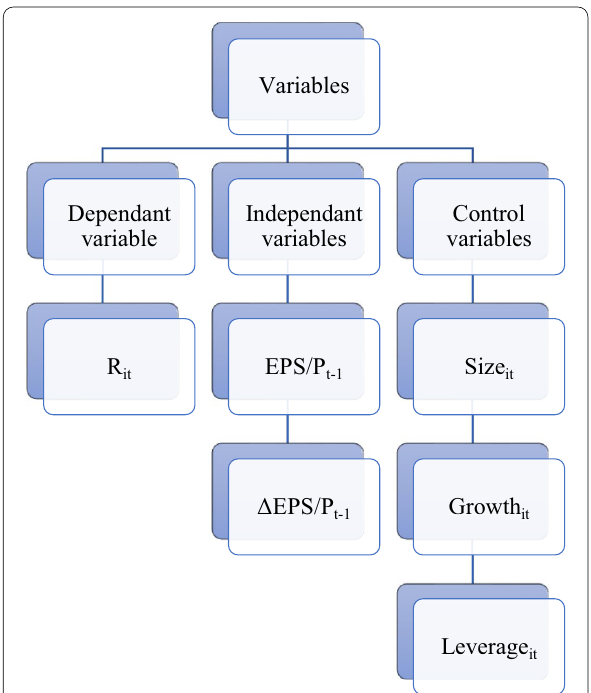
Fig. 2 The further analysis variables